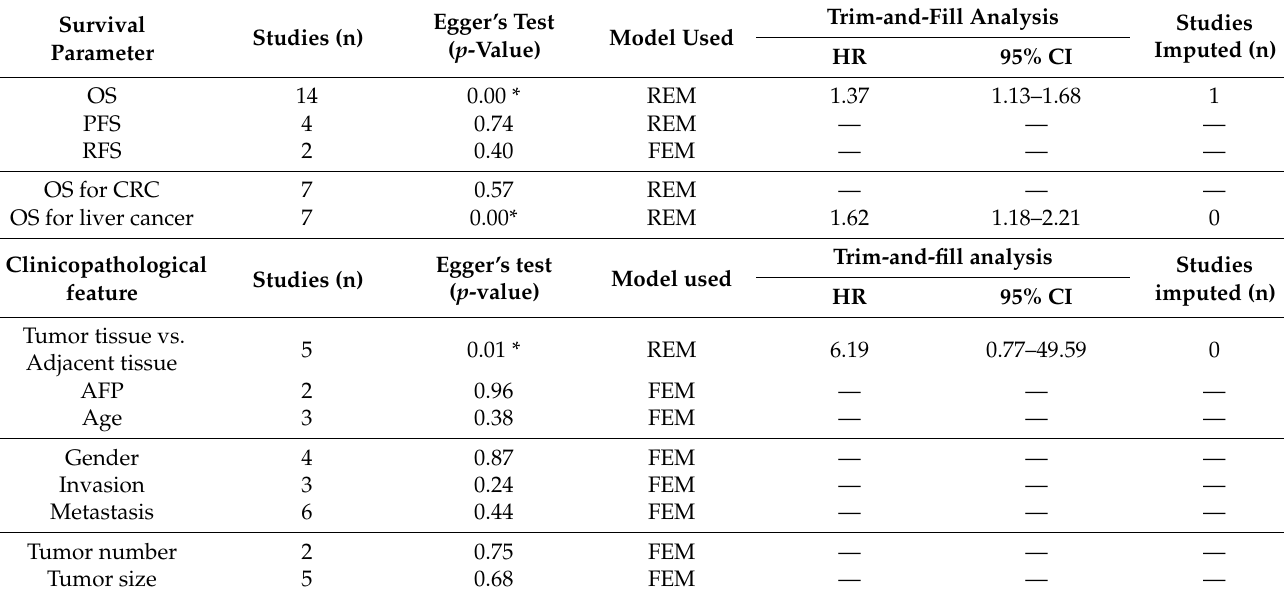
Table 4. Evaluation of risk of publication